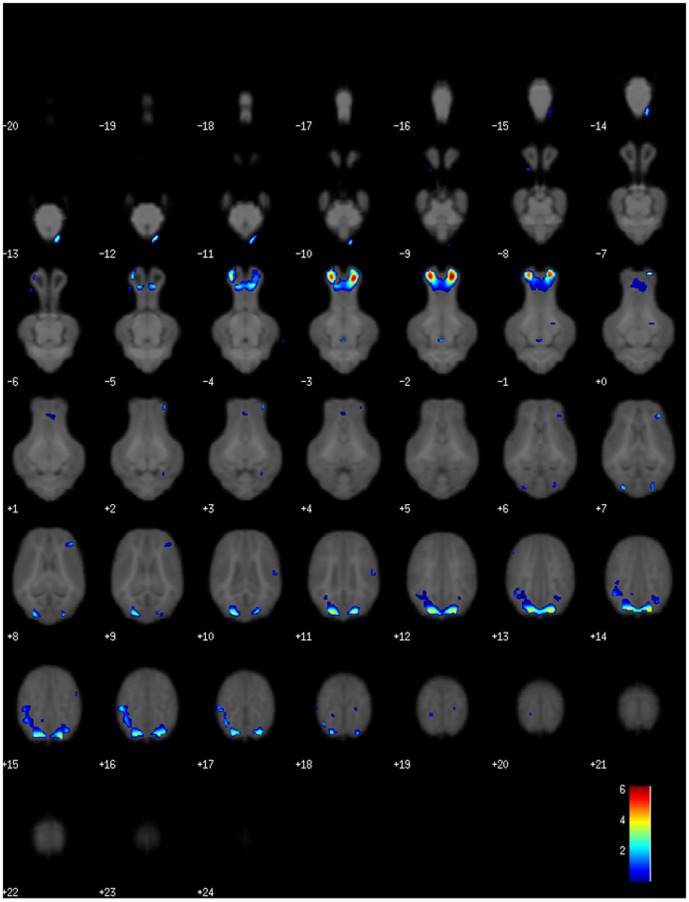
Voxel-based morphometry analysis using DARTEL showed increased gray matter volumes in the olfactory bulb and cortex of SGA piglets.The color bar indicates the pseudo-t statistic indicating level of significance.